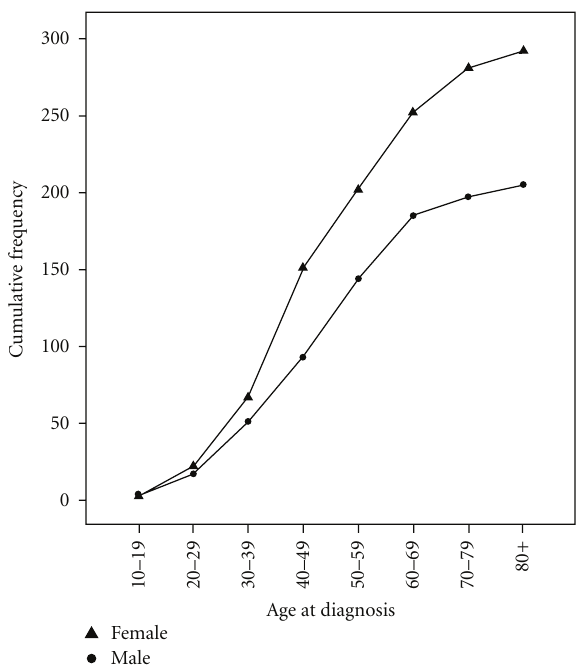
Figure 1: Cumulative frequency distribution of age-specific rates for cutaneous melanoma in the western region of Santa Catarina, Brazil, by gender from 2002 to 2009 (xy men and xy